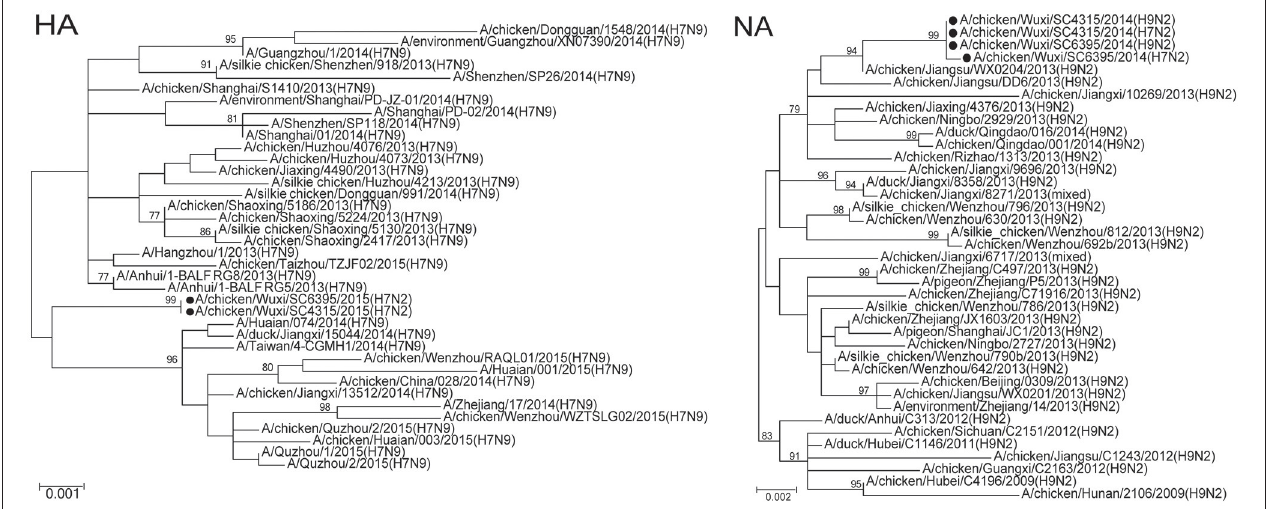
FIGURE 2 | Phylogenetic tree of hemagglutinin (HA) and neuraminidase (NA) genes of influenza A (H7N2) viruses isolated from sentinel chickens, Wuxi City, Jiangsu Province of China, 2014. Supporting bootstrap values > 75 are shown. The black circle dot indicates the viruses isolated in present study.